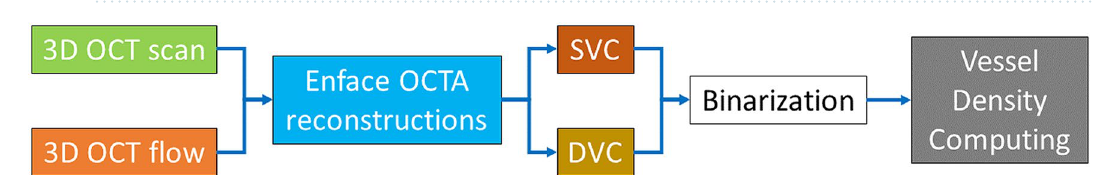
Figure 1. Graphical steps for vessel density calculation. SVC superficial vascular complex, DVC deep vascular complex.